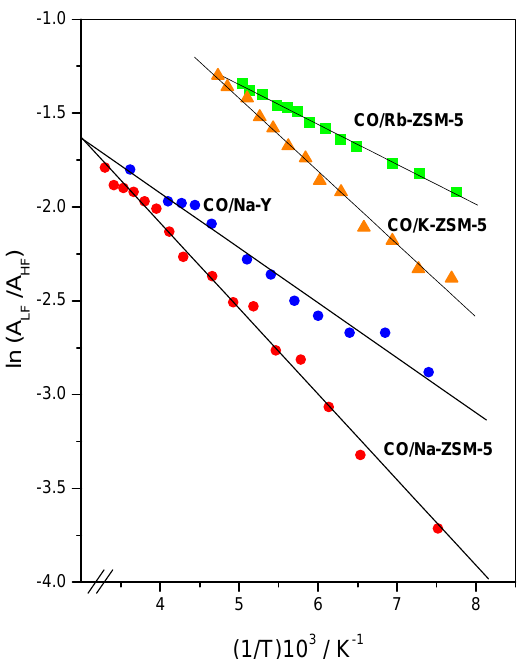
Figure 3. The van’t Hoff plots of the natural logarithm of the intensity ratio for LF and HF bands vs . reciprocal temperature.